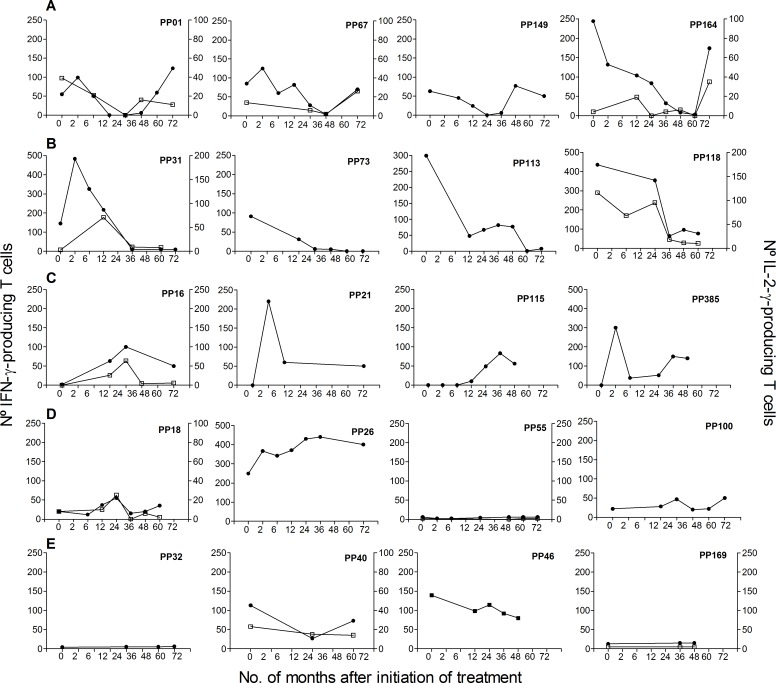
Monitoring of IFN-γ and IL-2 production in subjects with chronic Chagas disease and treated with benznidazole.IFN-γ– or IL-2-producing T cells were measured at different time points after benznidazole treatment or enrollment (for untreated subjects). Plots exhibit representative data for single subjects with different kinetics of T cell responses after benznidazole-treatment. Time 0 indicates the assay point just prior to benznidazole treatment. A) Parasite-specific T cell responses became undetectable after treatment and show a rebound thereafter. B) Parasite-specific T cell responses decreased after treatment. C) Previously undetectable cytokine-producing T cells prior to treatment became detectable after treatment. D) The frequencies of cytokine-producing T cells did not change relative to pretreatment. E) Monitoring of T cell responses in untreated subjects.